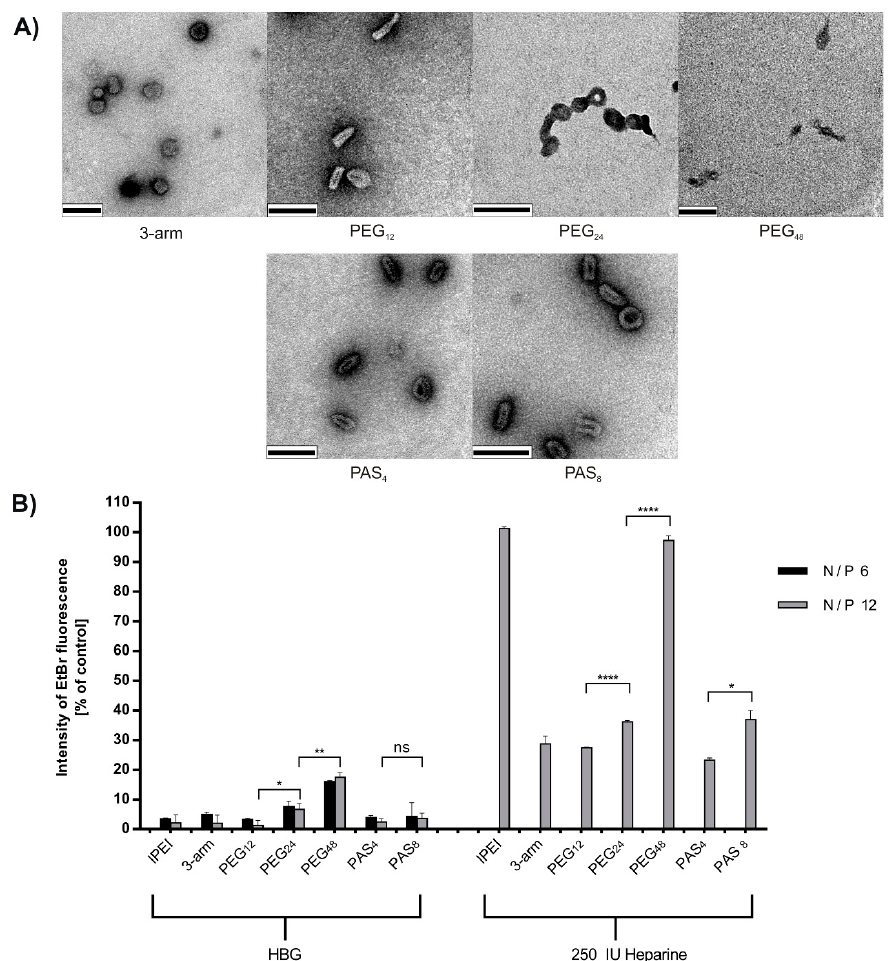
Figure 2. ( A ) Transmission electron microscopy images of polyplexes formed at N/P 12 in deionized water and stained with uranylformate. Scale bar represents 100 nm; ( B ) Left : pDNA compaction, correlating with the remaining fluorescence of ethidium bromide (EtBr). Results are calculated against free pDNA. Right : Polyplexes at N/P 12 after addition of 250 IU of heparin. lPEI: linear polyethylenimine. Statistical analysis (Student’s t -test): ns p > 0.05, * p ≤ 0.05; ** p ≤ 0.01; *** p ≤ 0.001, **** p ≤ 0.0001.